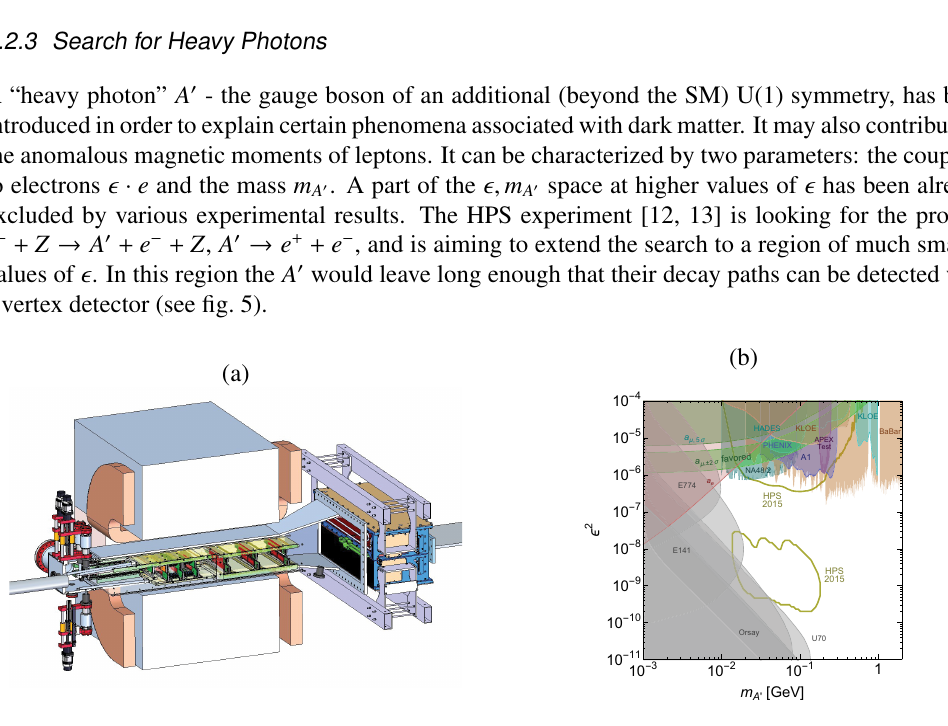
Figure 5. (a) Layout of the HPS experiment [12]. A thin target is located close to a dipole magnet. The trajectories are detected with a silicon vertex detector located very close to the electron beam. The electrons are identified with a EM calorimeter. (b) - the projected zone of sensitivity of the HPS